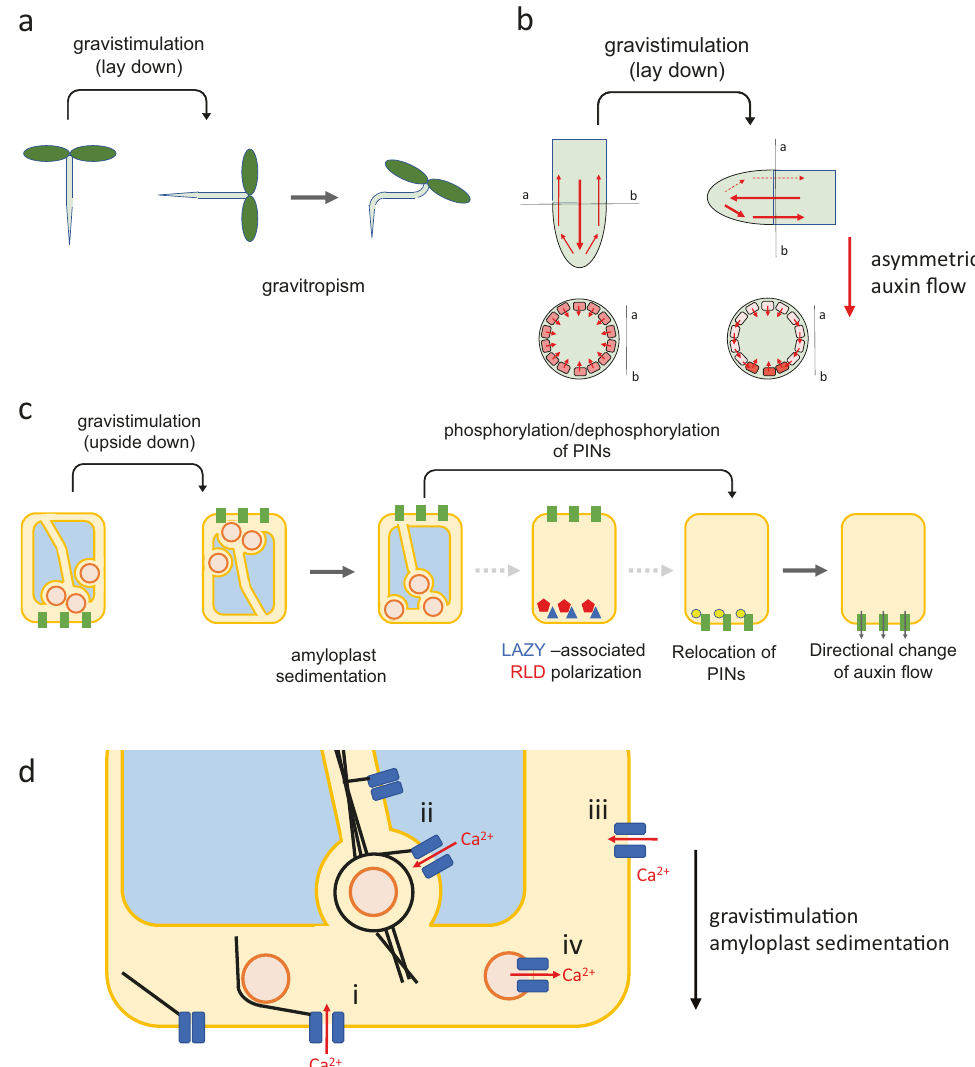
Fig. 1 Mechanism for directional growth in response to gravity in plants. a Model of gravitropism. b Asymmetric auxin fl ow in horizontally reoriented plants, c cellular responses in gravisensing (endodermal) cells. At fi rst, gravity causes sedimentation of amyloplasts. RLD proteins associated with LAZY proteins get polarized to the new bottom side. The LAZY proteins regulate the localization of PIN proteins, which are ef fl ux carriers of plant hormone auxin. Finally, the change in direction of auxin fl ow causes asymmetric growth of plants. d Activation of mechanosensitive ion channels in plasma- and endomembrane upon amyloplast sedimentation (i, ii), deformation, compression and shear stress (iii), displacement of amyloplast